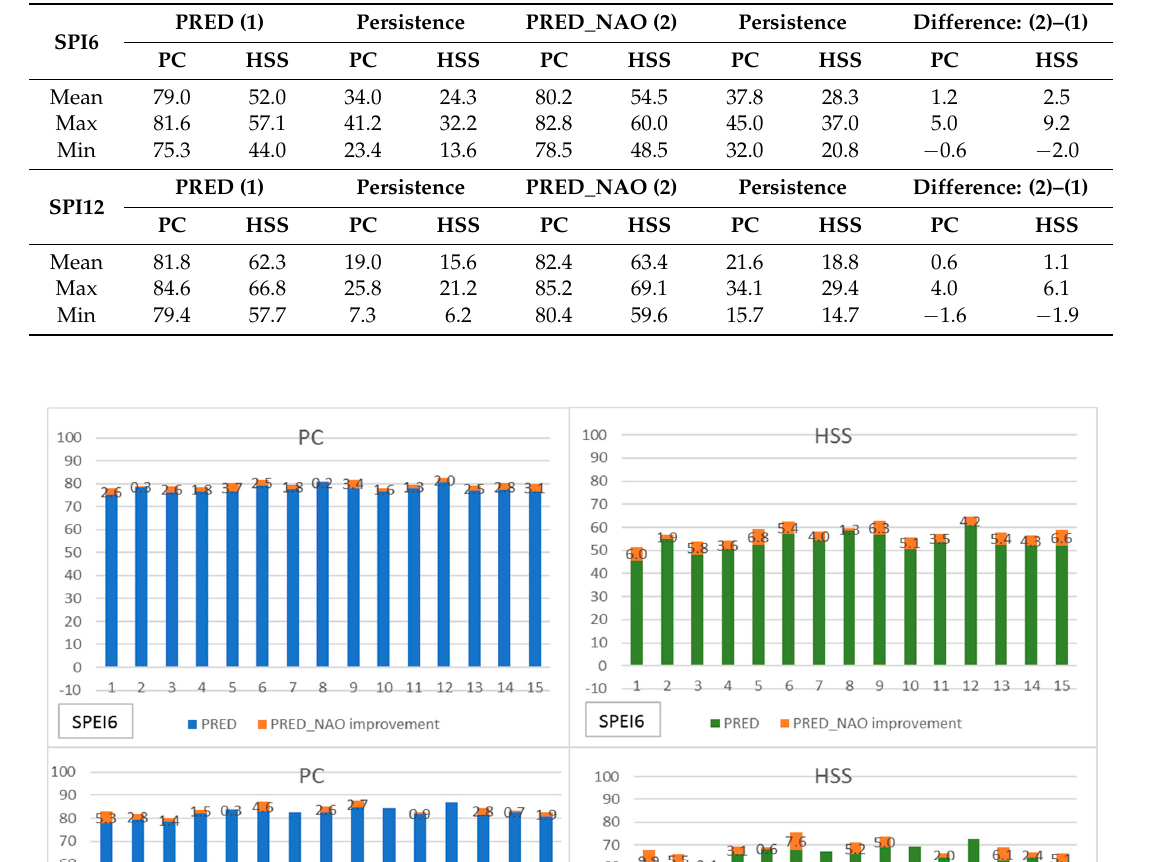
Table 11. As in Table 9 but relative to all months and SPI6 (above) and SPI12 (below).